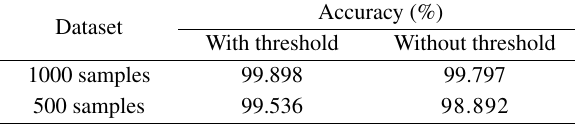
Table 3 Accuracy comparisons with/without threshold in different samples of limited labeled datasets in Case